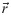
Illustrative example of a Switching Linear Dynamical System (SLDS).The stochastic dynamics of the (simulated) particle is denoted by thin red line (i.e., the trajectory of r→) and the simulated discrete measurements, ψ→, are represented by the grey lines with symbols. The parameter determining the linear dynamical system is denoted by θ
z. At random times, the latent state z changes and hence the underlying parameter specifying the dynamics, θ
z, also changes. Note that θ
z models both thermal and measurement noise (parameters defined in Eq (1)). The latter is crucial for identifying subtle changes in the underlying stochastic process. For example, the dramatic change in thermal fluctuations shown around observations 300–400 would be difficult to detect without jointly modeling thermal and measurement noise. To achieve this joint modeling, one must also account for temporal correlations induced by measurement noise [18, 36, 37].